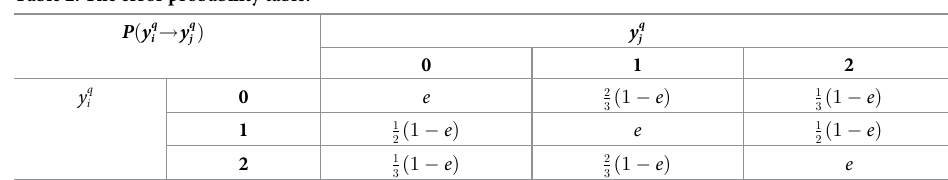
Table 2. The error probability table.